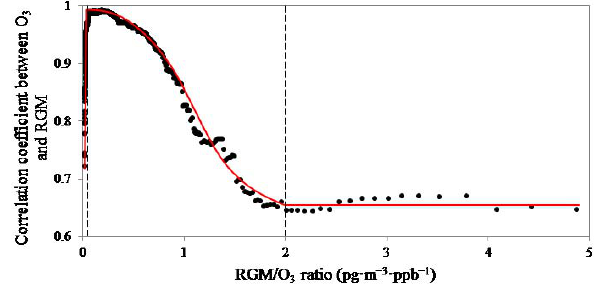
Fig. 8. Relationship between RGM/O 3 ratio and O 3 –RGM corre- lation coefficient.